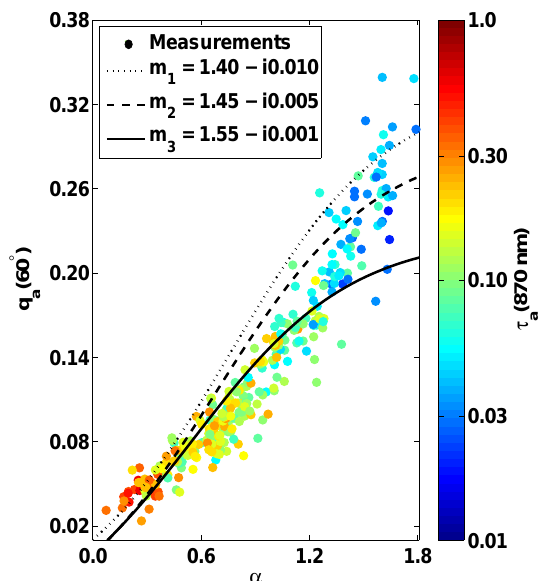
Fig. 9. q a ( 60 ◦ ) versus α for 305 retrieved data points (colored cir- cles). Lines are calculated for three different assumed refractive in- dices based on the Mie scattering